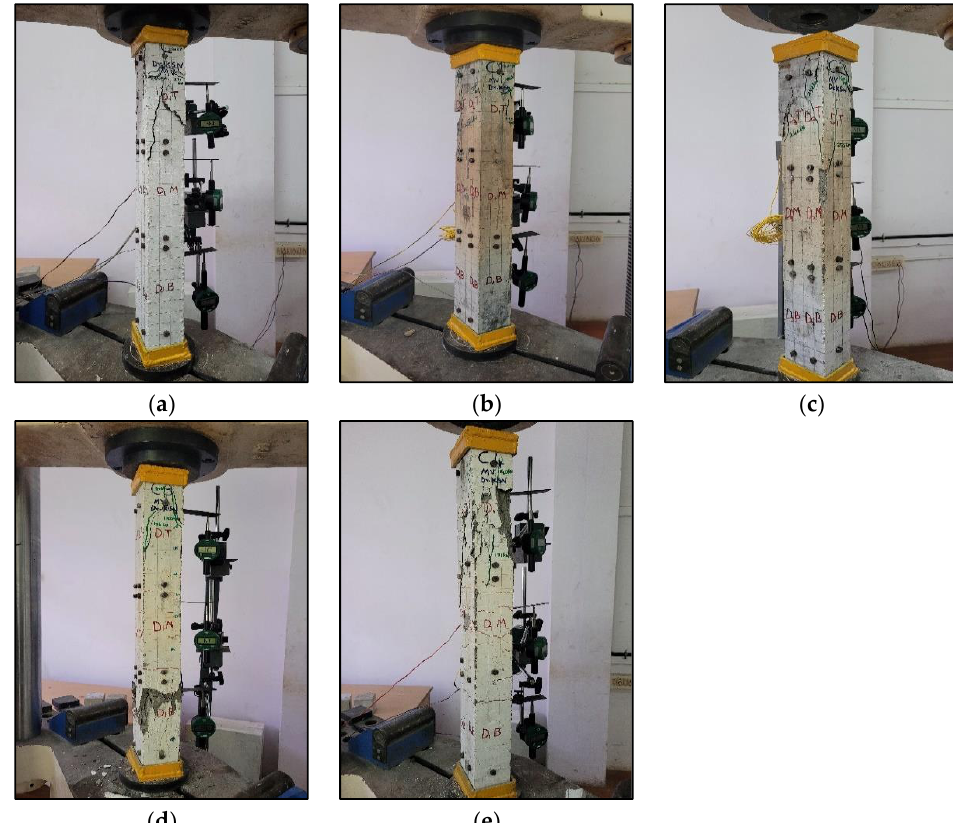
Figure 33. Load versus deformation profile of the specimens: ( a ) Top, ( b ) Middle, and ( c ) Bottom.